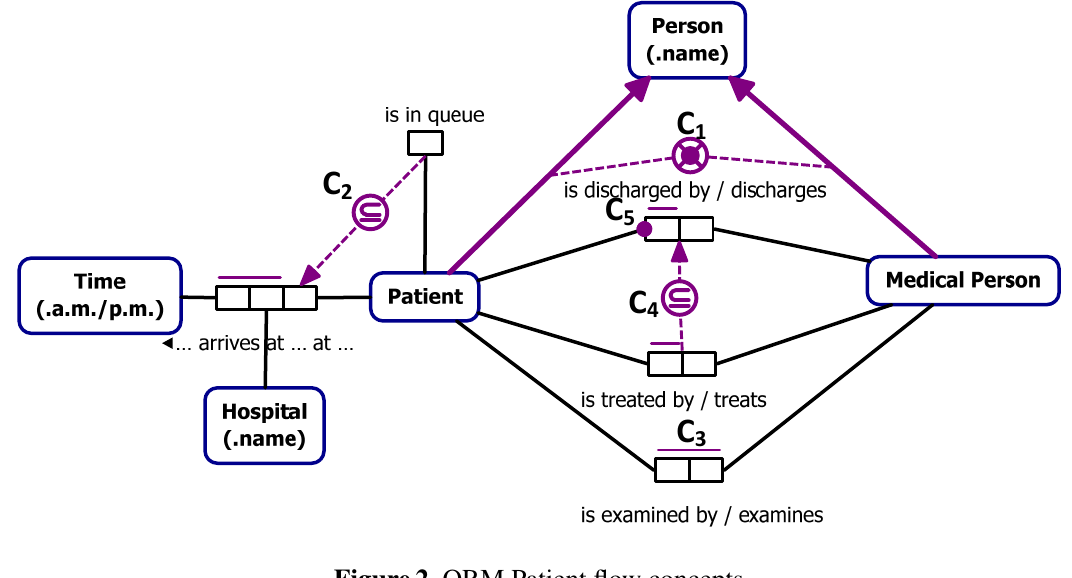
Figure 2. ORM Patient flow